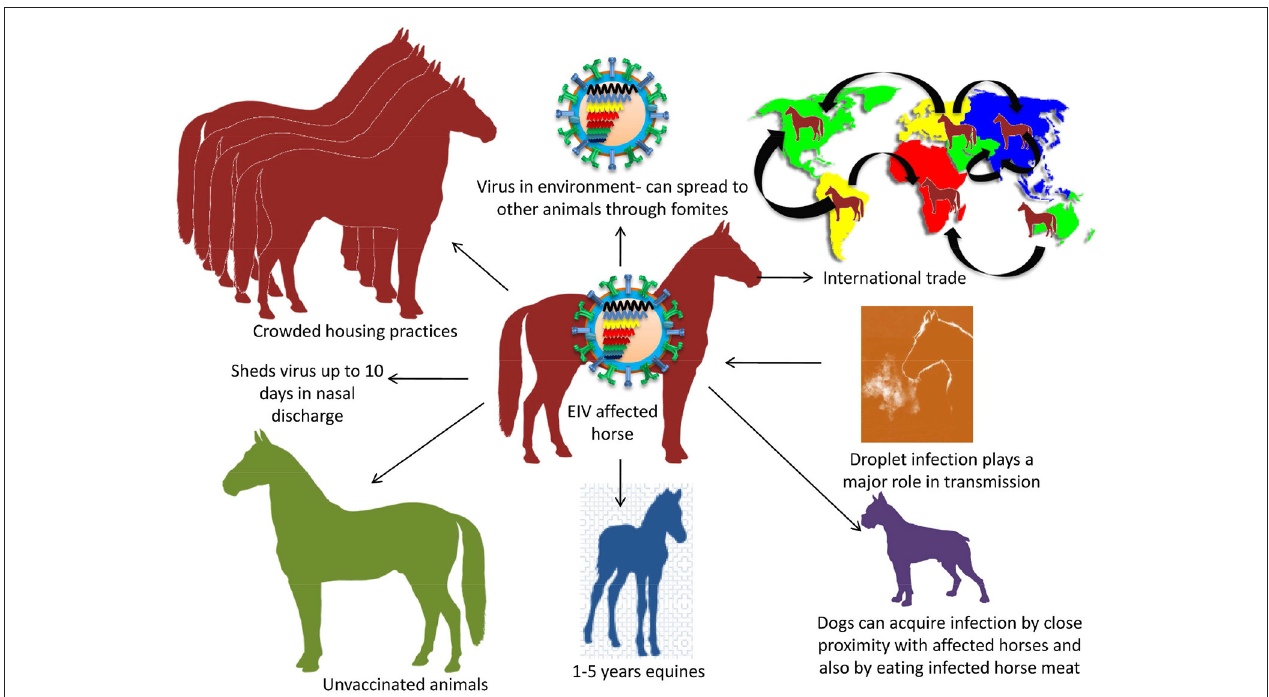
FIGURE 3 | Transmission of EIV. Droplet infection is an important mode of transmission. Transmission between animals includes crowded housing practices, non-vaccination, young horses of 1–5 years and international trade. Dog gets EIV by consuming infected dead horse meat.